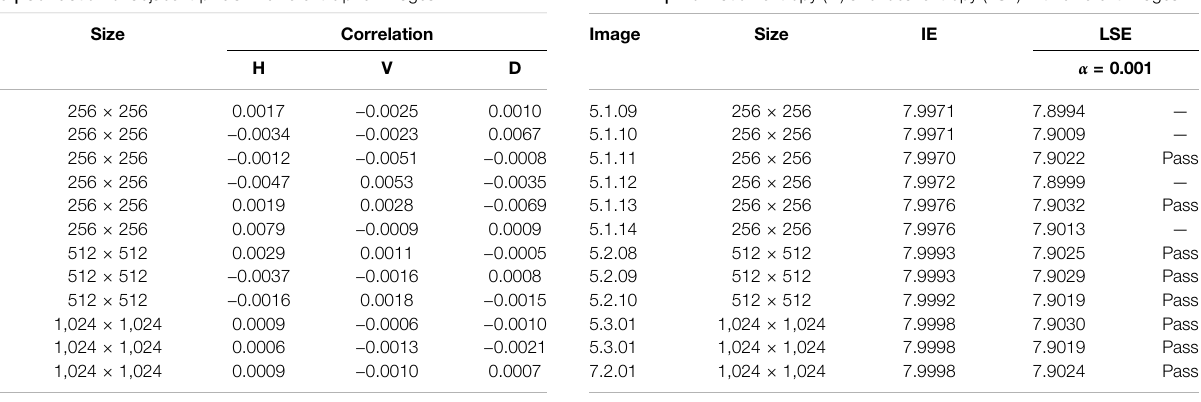
TABLE 5 | Correlation of adjacent pixels in different cipher images.